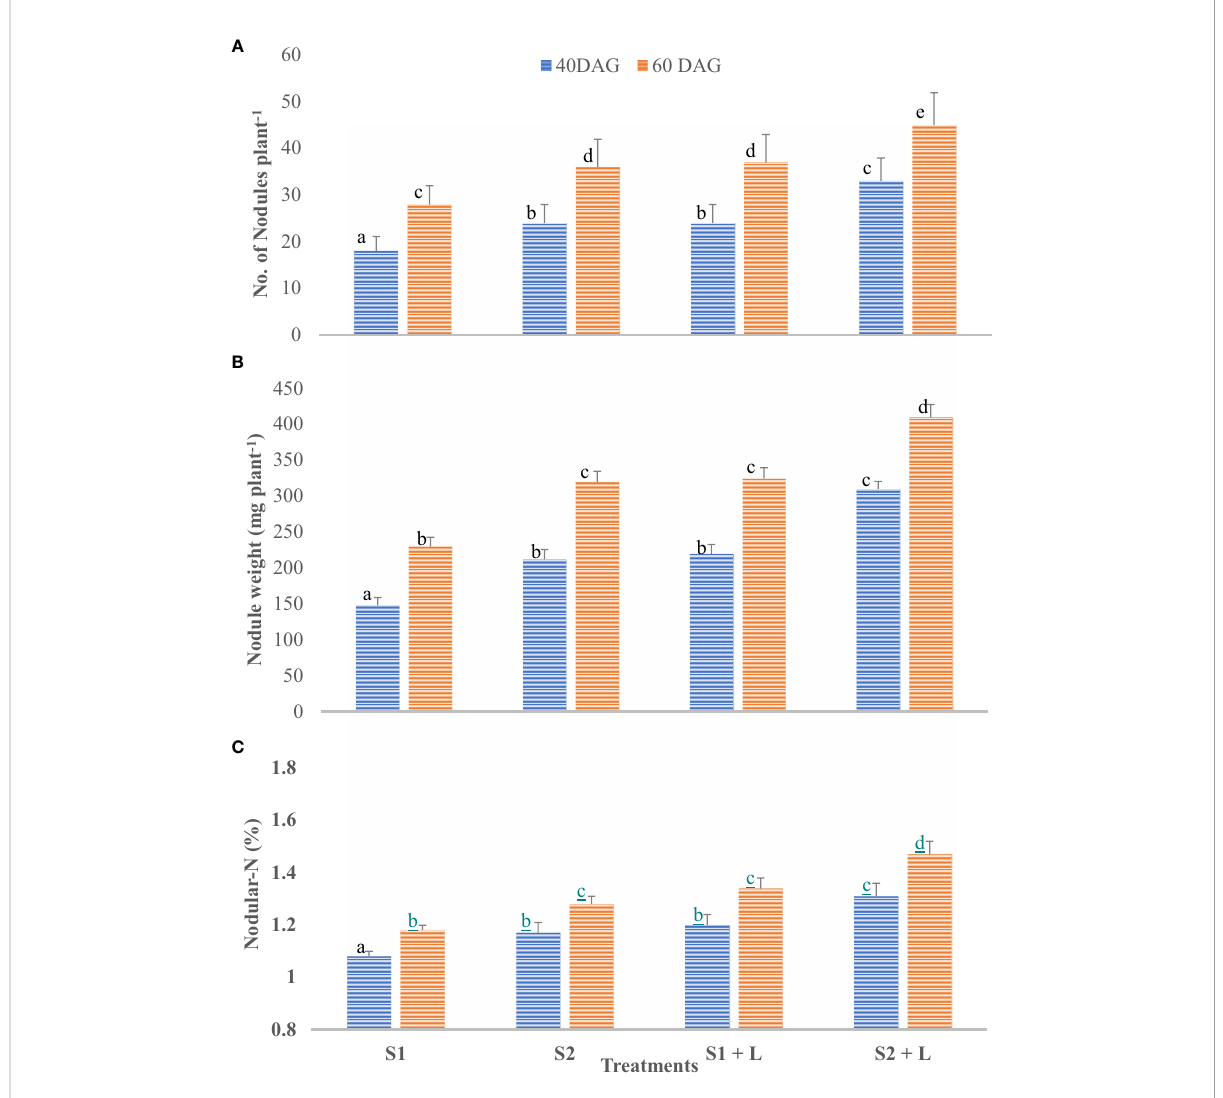
FIGURE 4 In fl uence of Rhizobium strains inoculation of seed on nodular characteristics of French bean. (A) Nodule number. (B) Nodule weight. (C) Nodular-N. T-shaped bar at the top of each bar indicates standard error (SE), and different letters on top indicate statistical difference (Duncan ’ s multiple-test range), p =